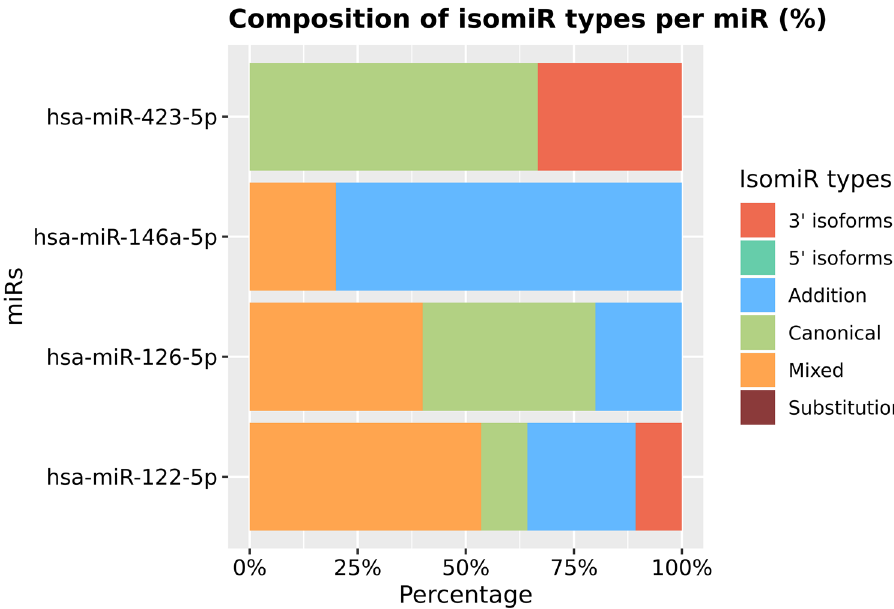
Figure 3. isomiRs fraction for the miRNAs miR-122-5p, miR- 126-5p, miR-146a-5p and miR-423-5p.